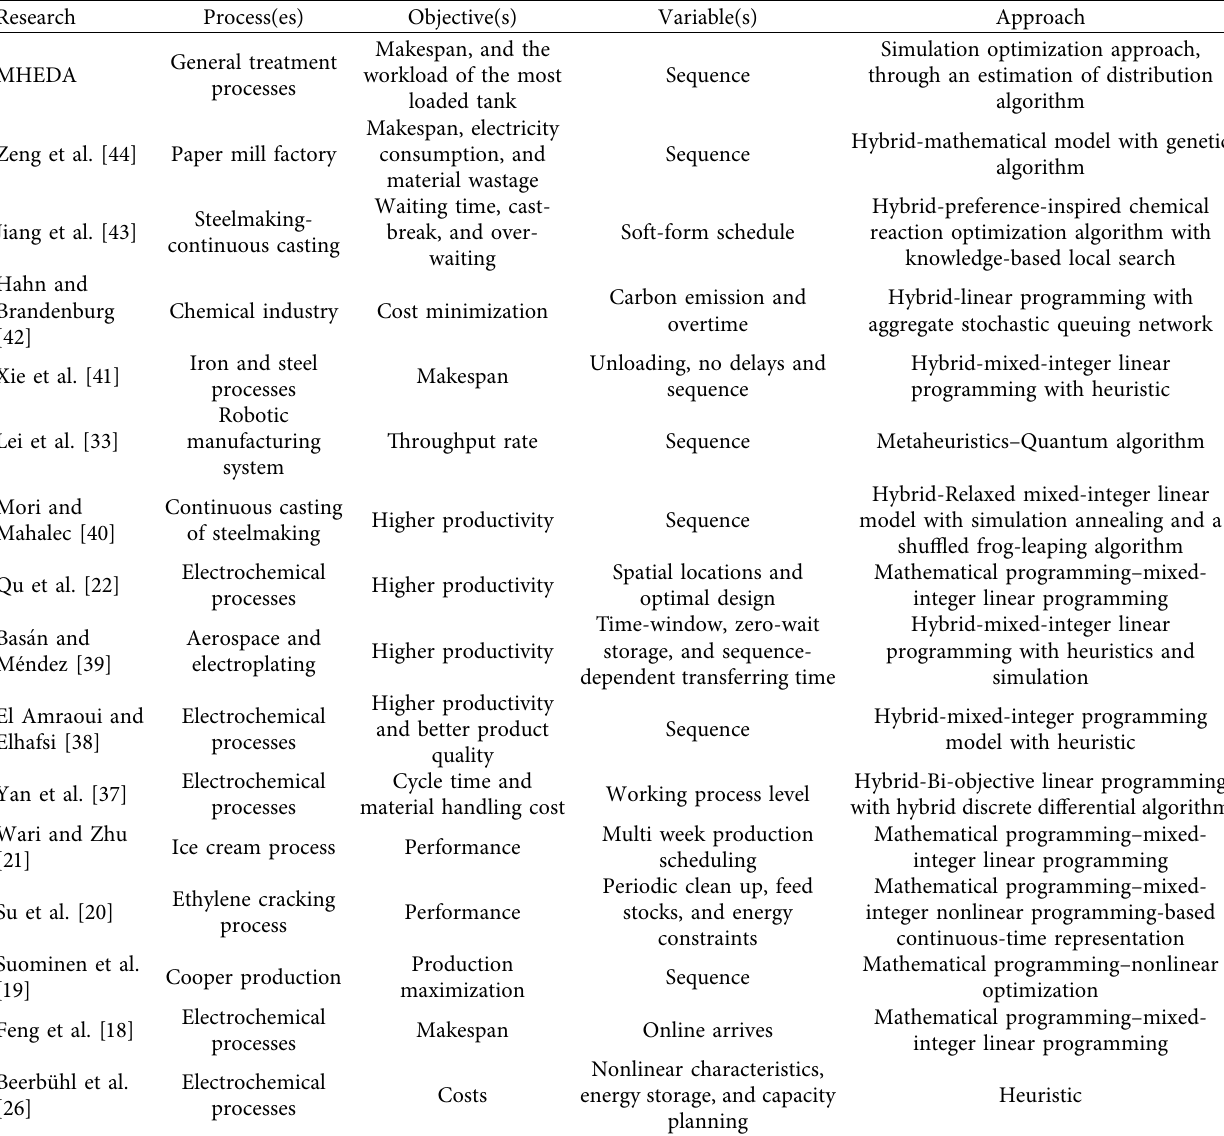
Table 4: Literature review of the